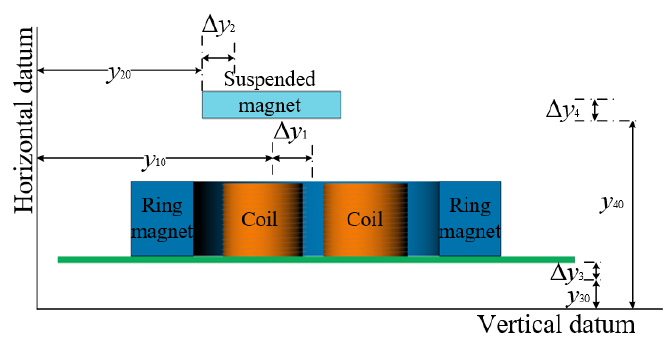
Figure 3. Measuring